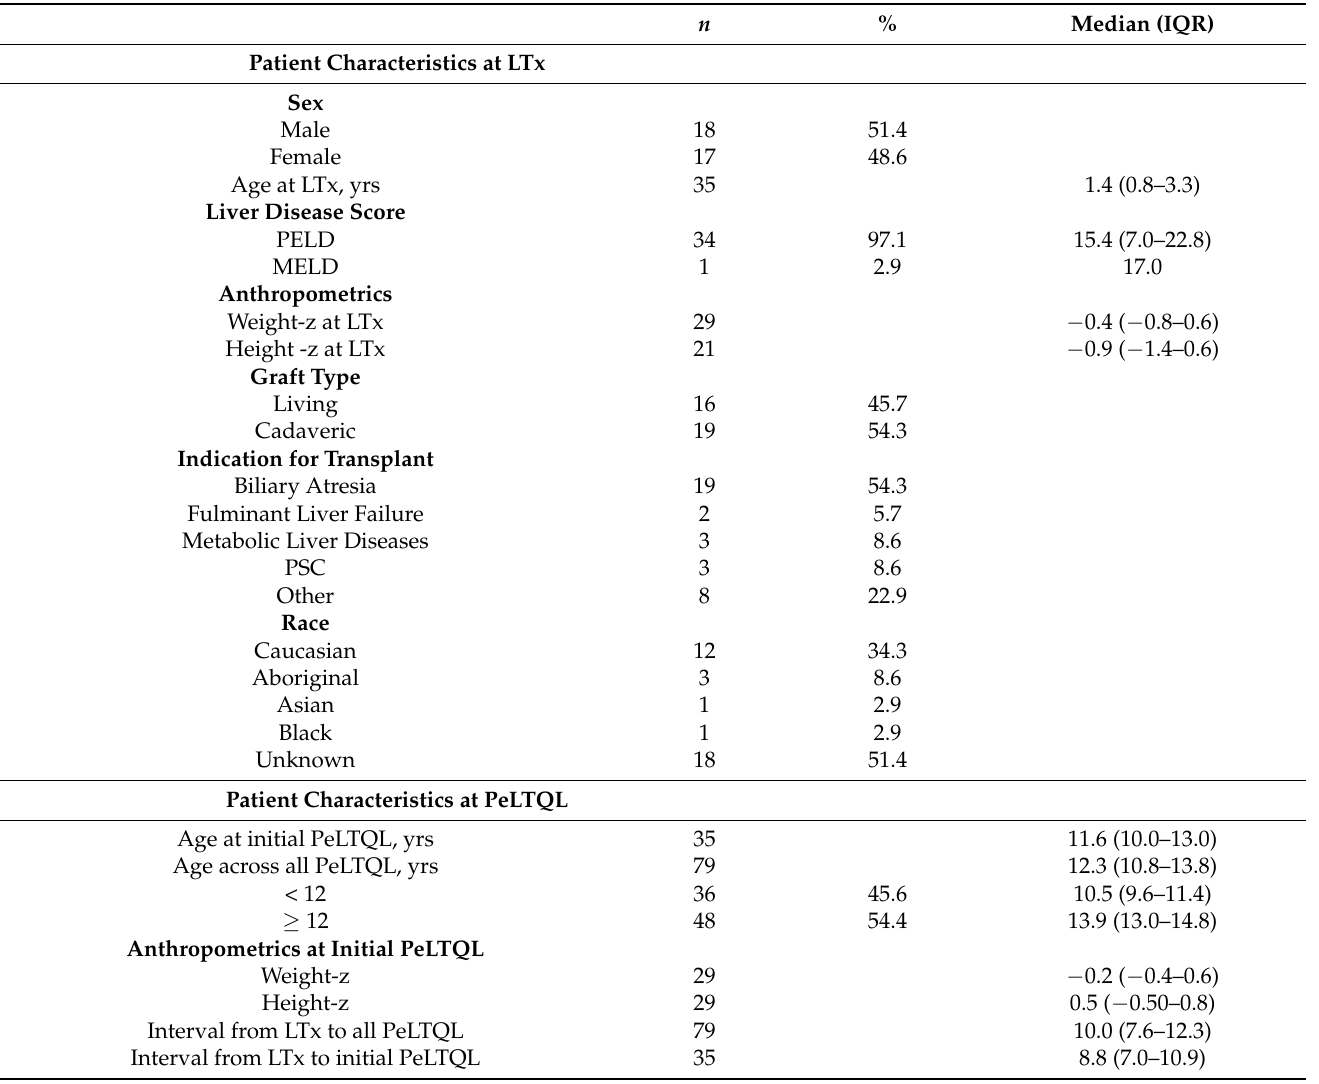
Table 1. Demographic and medical